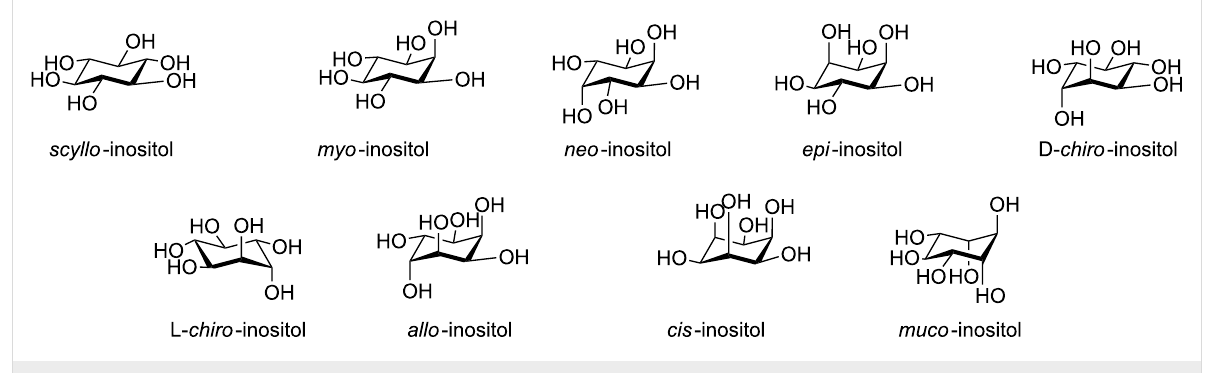
Figure 1: Stereoisomeric